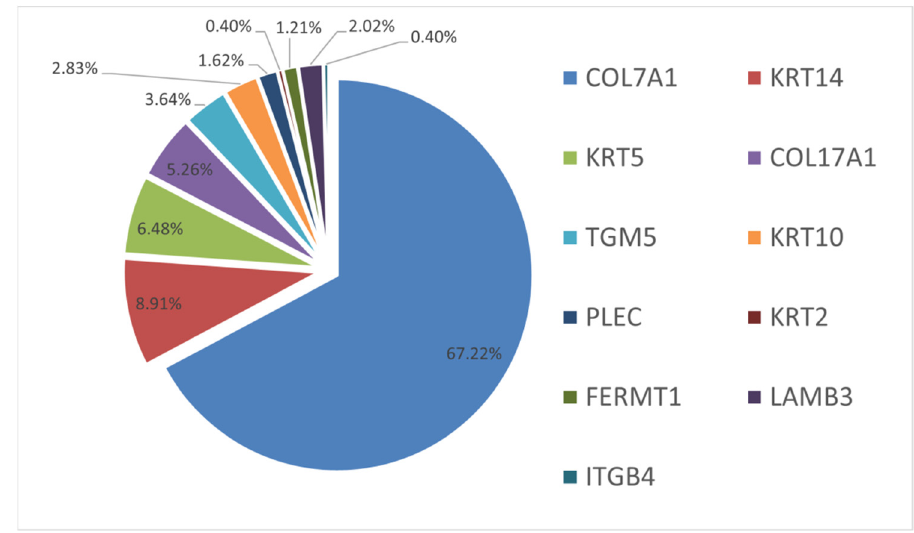
Figure 2. Variety of genes and the proportion of mutations in 247 examined families with the EB phenotype.